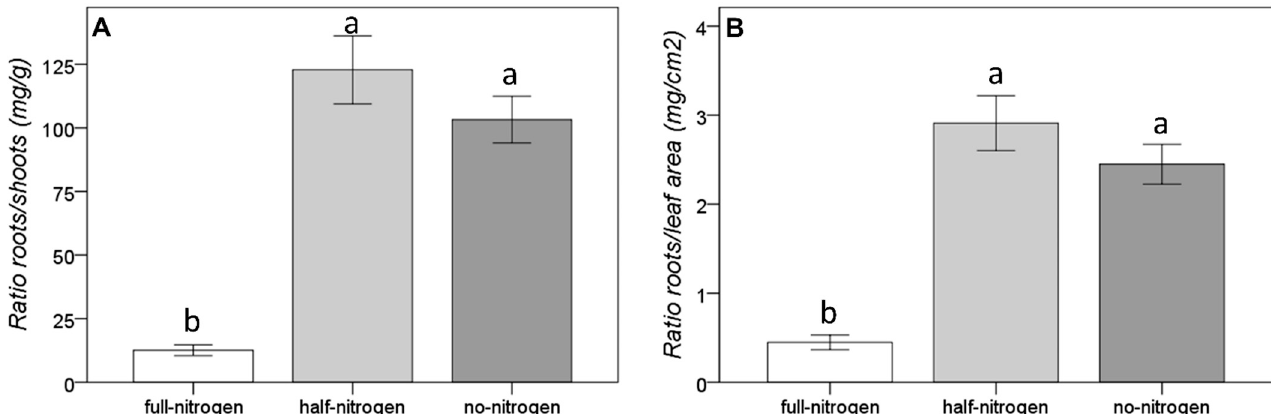
Figure 3. Effect of the short-term nitrogen deficiency on the proportions of the hypogeal and the epigeal parts (( A ): ratio roots/shoots; ( B ): ratio roots/leaf area). Bars represent the standard error; different letters indicate significant differences among group results found by the Duncan post-hoc test.